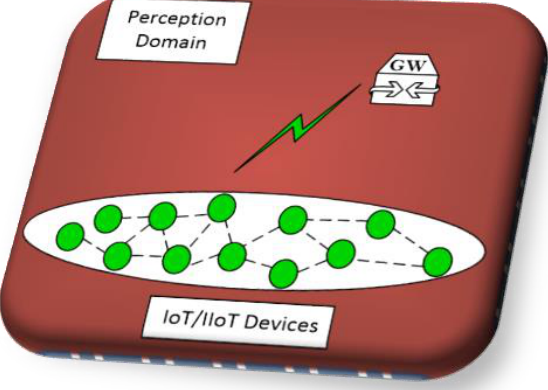
Figure 1. IoT/IIoT Network (Perception Domain).